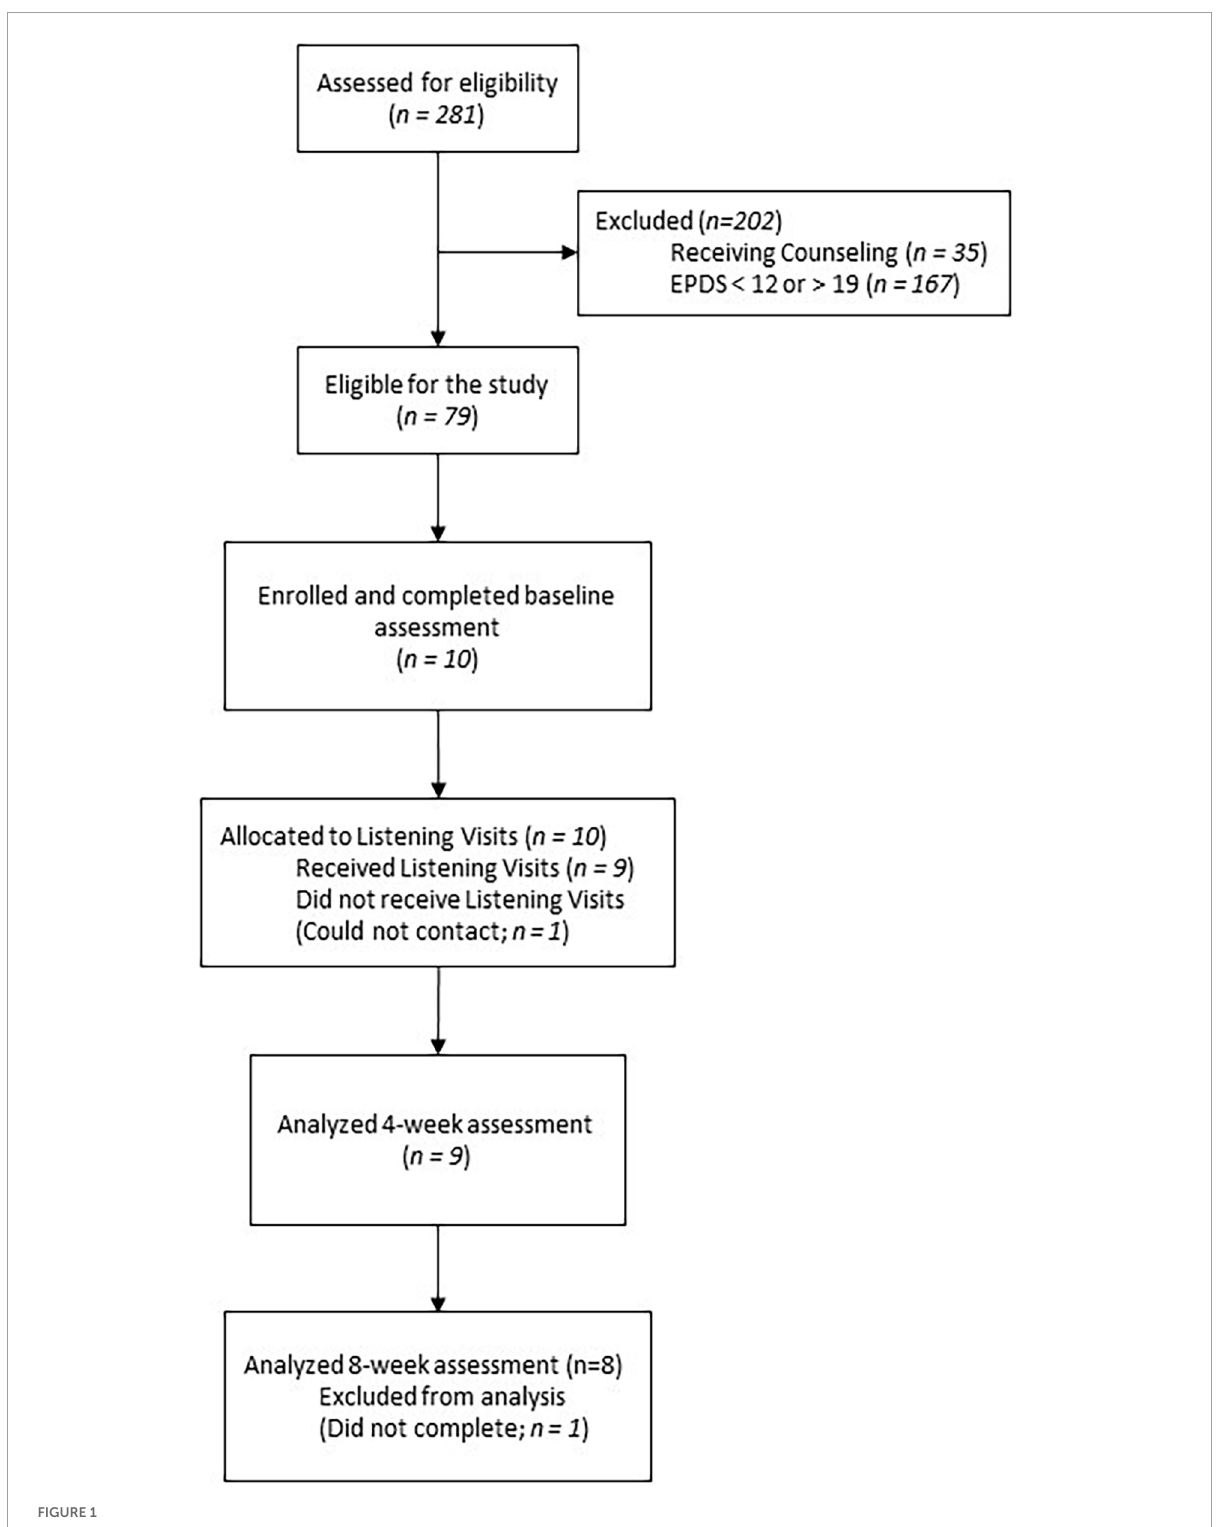
FIGURE1 Consort flow